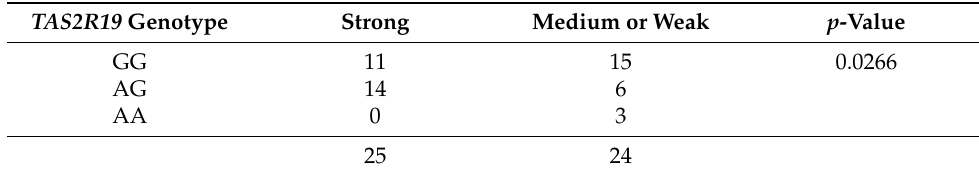
Table 3. Genotypes for TAS2R19 in subjects rated 1 mM quinine as equal to or more than “strong” or below “strong” (medium or weak). The variants G and A result in arginine and cysteine respectively of the TAS2R19 299th amino acid (through the complementary strand). The p -value was calculated by Fisher’s exact test.